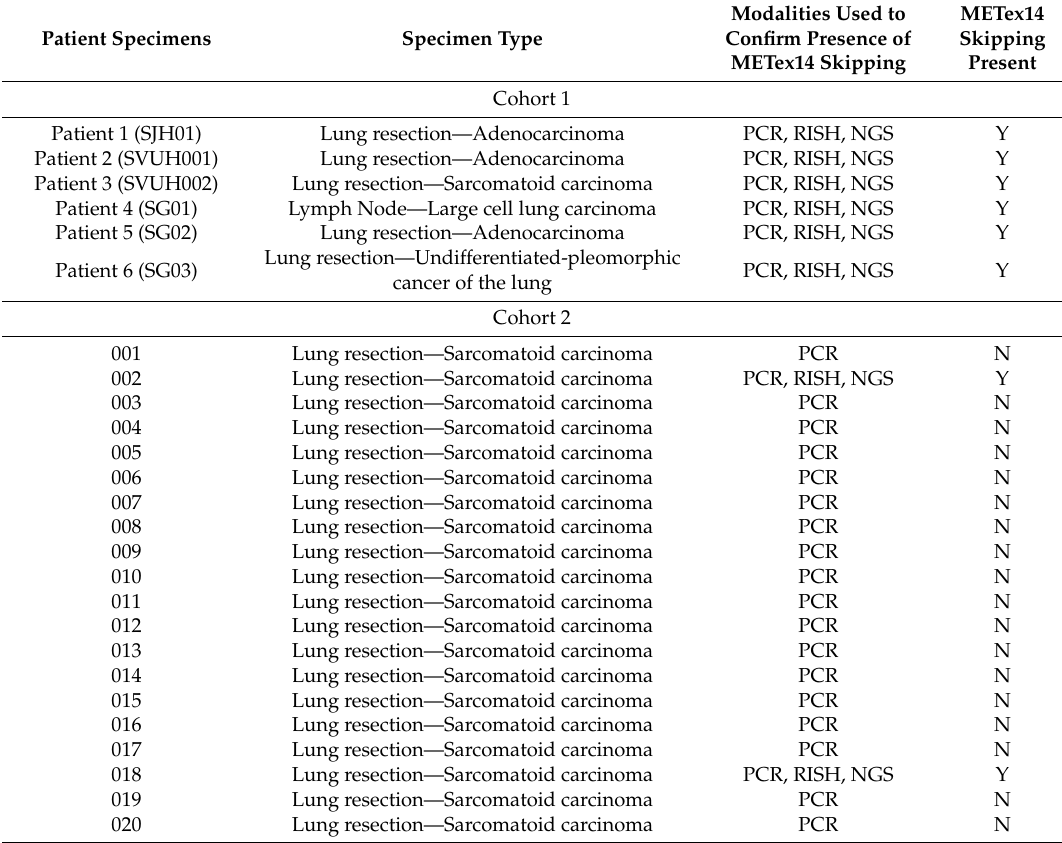
Table 1. Patient samples used in this